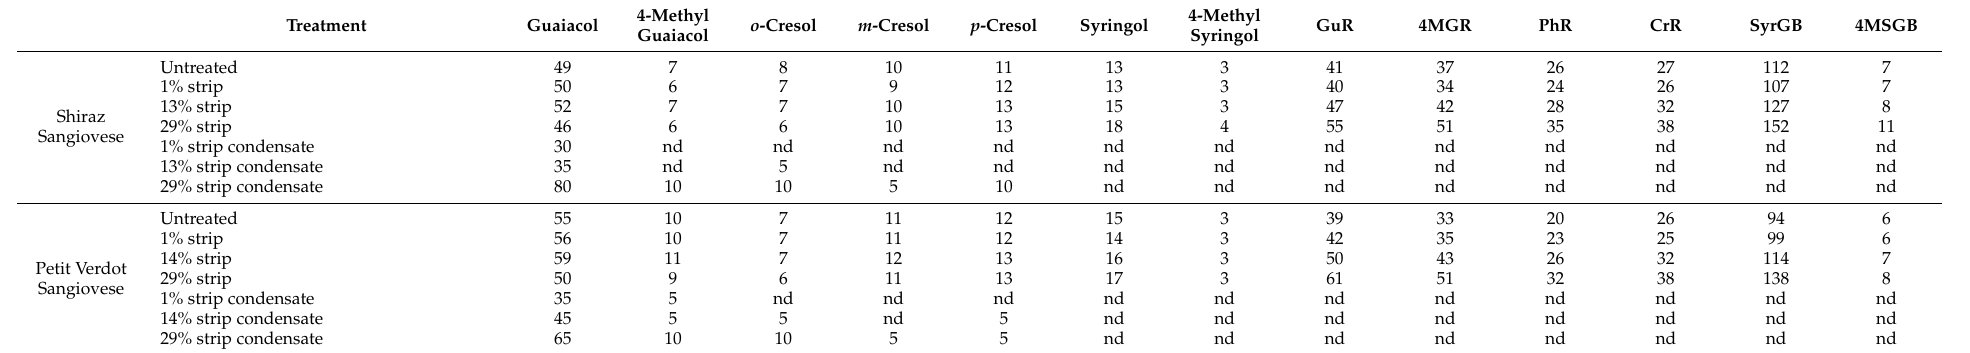
Table 2. Concentrations of volatile phenols and their glycoconjugates ( µ g/L) in smoke-tainted Shiraz Sangiovese and Petit Verdot Sangiovese wines, before and after spinning cone column distillation, and in their corresponding